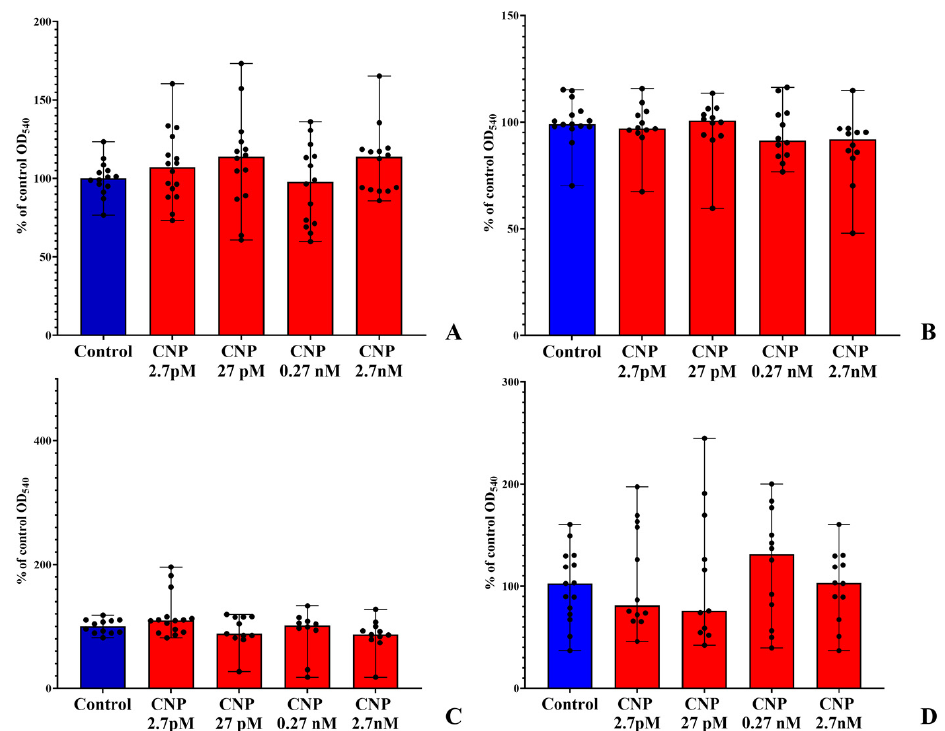
Figure 2. Effects of different CNP concentrations on planktonic cultures and biofilms of C. acnes on PTFE cubes. ( A ), 24 h planktonic cultures; ( B ), 72 h planktonic cultures; ( C ), 24 h biofilms; ( D ), 72 h